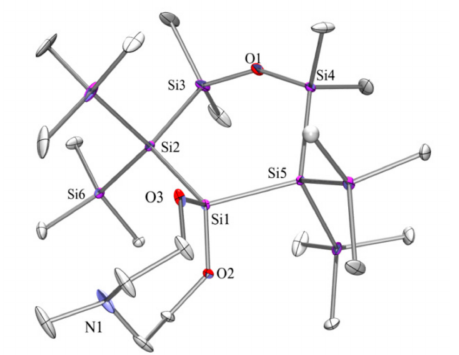
Figure 5. Molecular structure of 10 (thermal ellipsoid plot drawn at the 30% probability level). All hydrogen atoms are omitted for clarity (bond lengths in Å, angles in deg). Si(1)-O(2) 1.644(2),